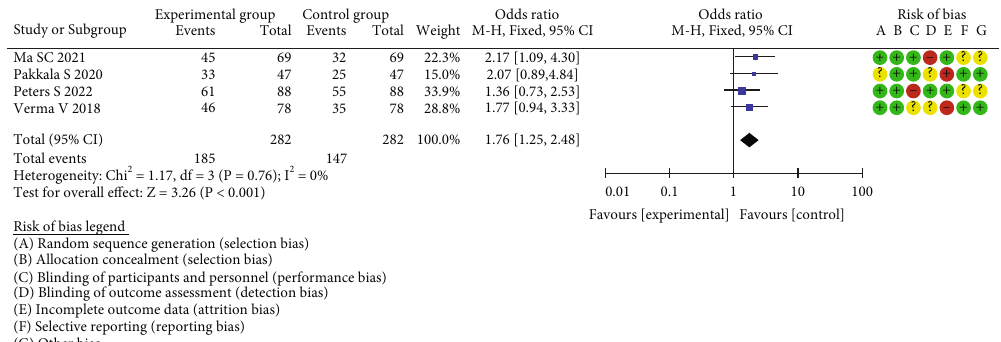
(D) Blinding of outcome assessment (detection bias) (E) Incomplete outcome data (attrition bias)